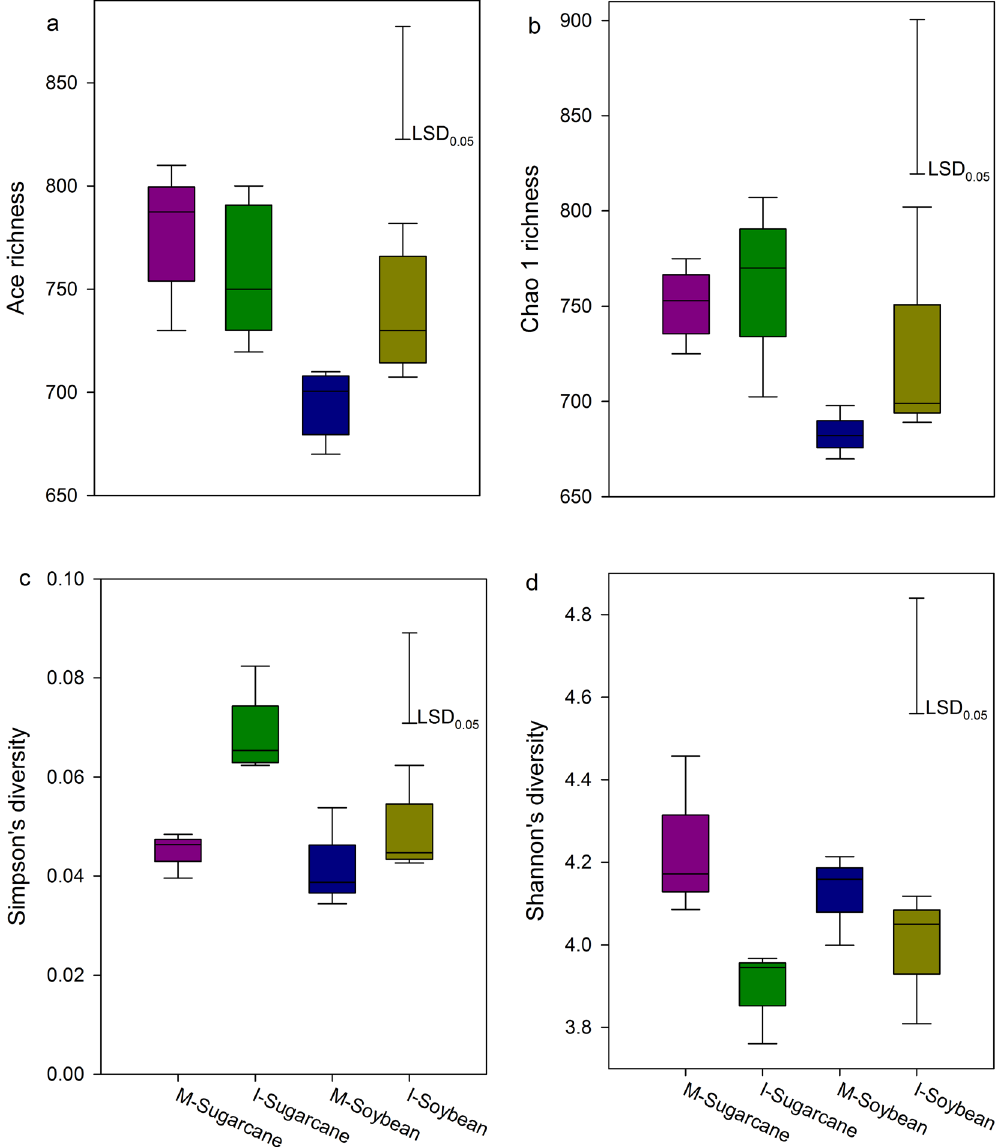
Figure 2. Illumina MiSeq sequencing of the fungal data and bacterial community diversity indices (at 97% sequence similarity) based on the ITS gene. ( a ) Ace richness ( b ) Chao 1 richness ( c ) Simpson’s diversity and ( d ) Shannon’s diversity. M-Sugarcane, sugarcane monoculture; I-Sugarcane, intercropped sugarcane. M-Soybean, soybean monoculture; I-Soybean, intercropped